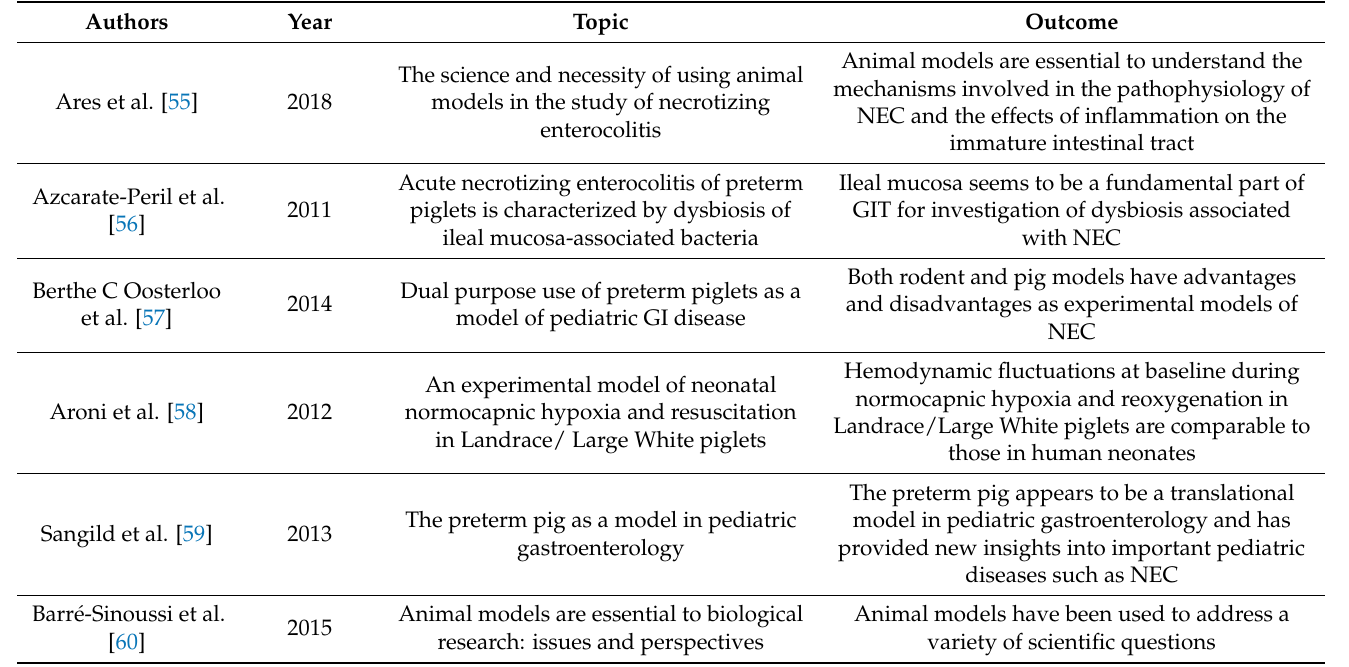
Table 6. Investigation of pathogenetic mechanisms of NEC and other common GIT diseases of neonates associated with microbiota and the use of different research